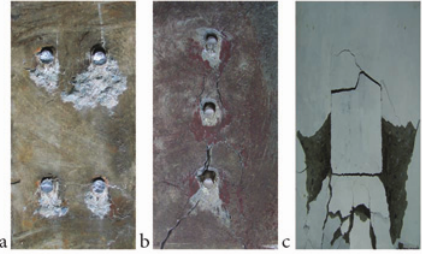
Fig. 1. Failure modes of shear connection: a – stud failure; b – stud failure after cracking; c – concrete failure